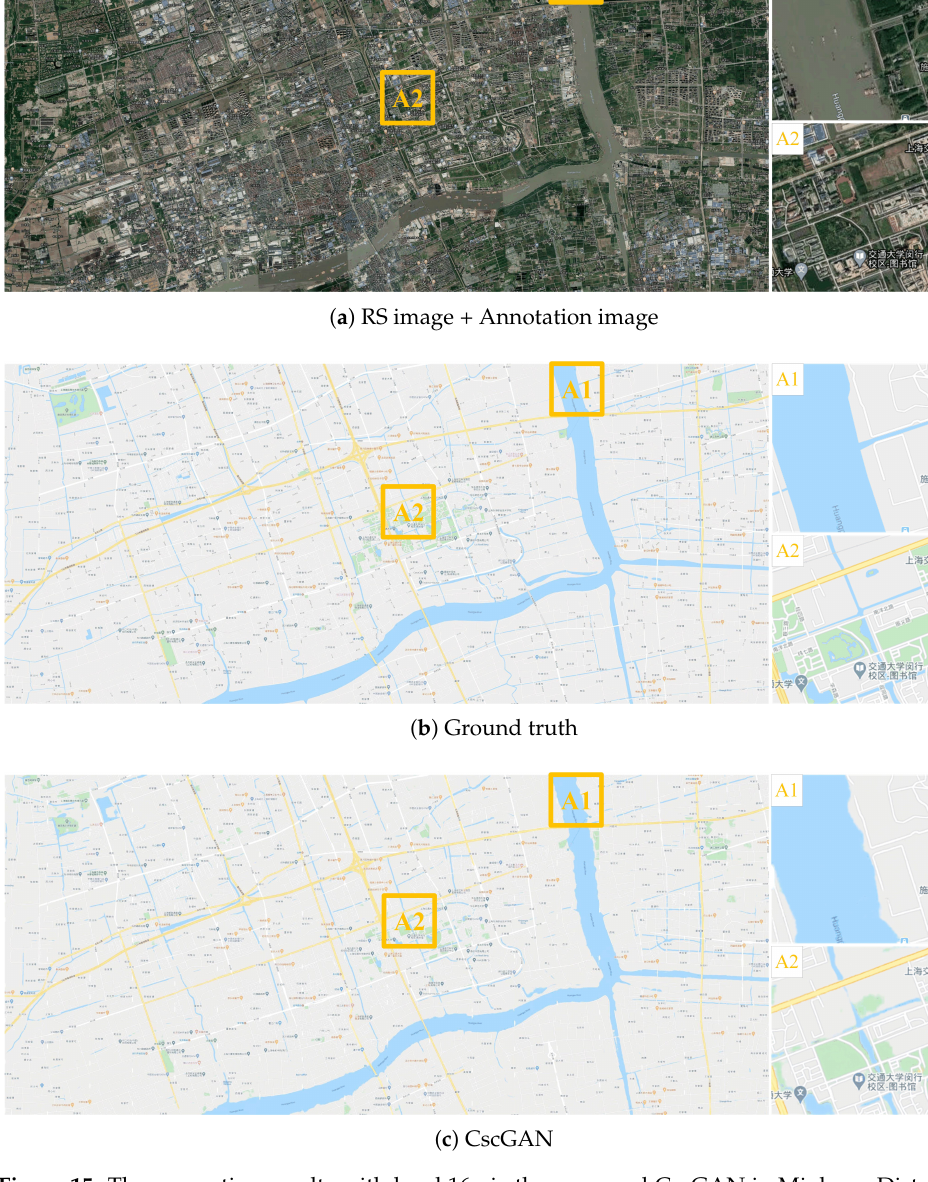
Figure 15. The generation results with level 16 via the proposed CscGAN in Minhang District of Shanghai. For clarity, the zoomed local areas (A1 and A2) are on the right of the figure.